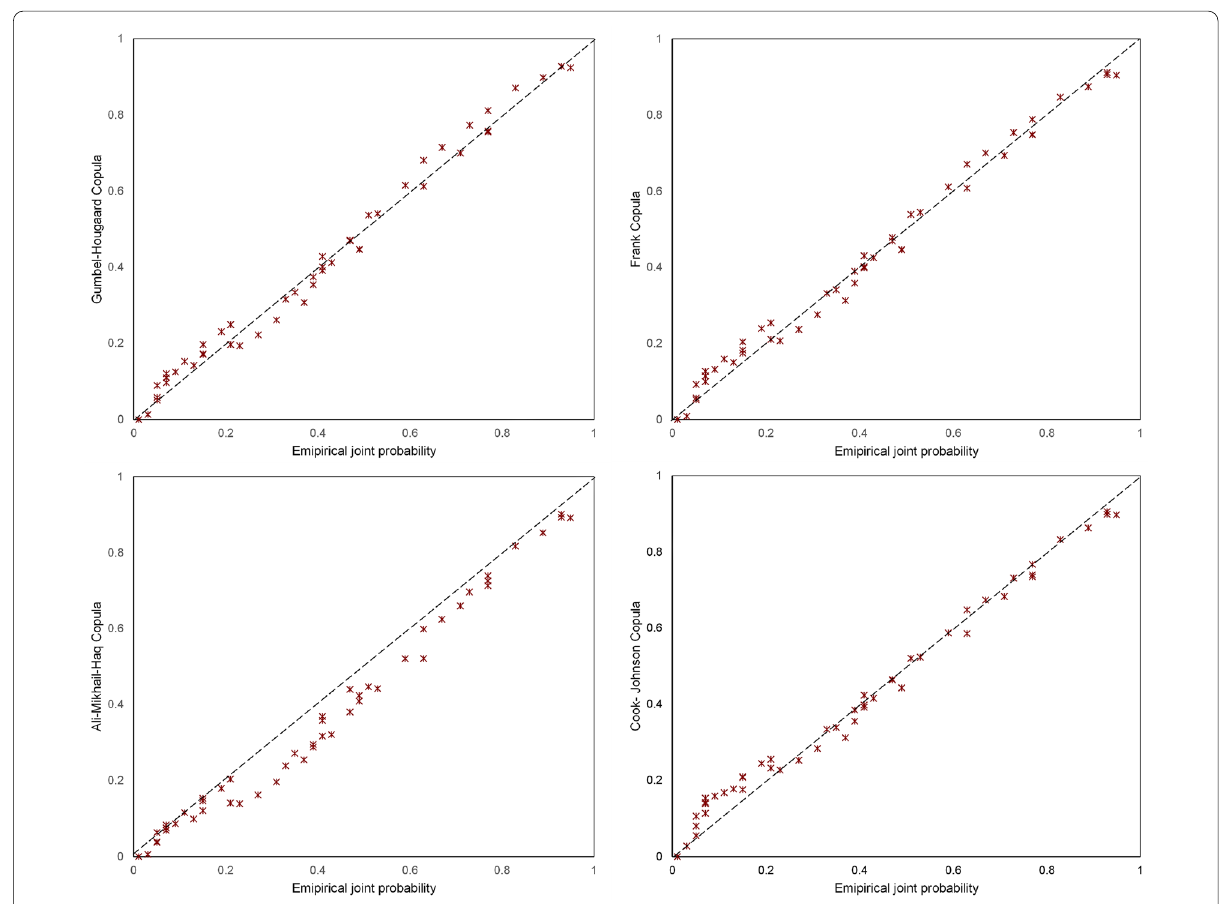
Fig. 7 Comparison of joint cumulative probabilities obtained through empirical equation and copula for flood peak and